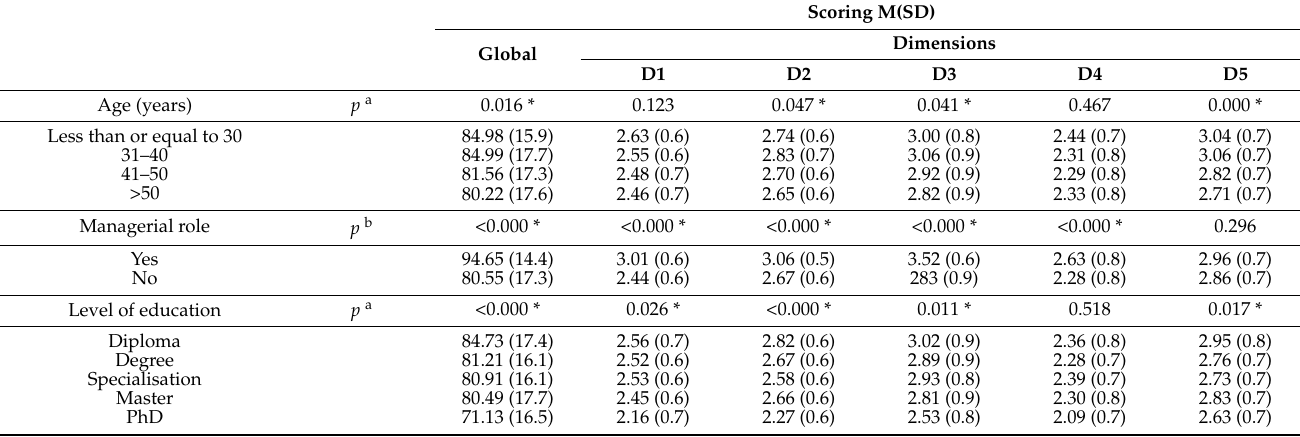
Table 2. Bivariate analysis of the results from PES-NWI and the sociodemographic and professional variables. Scoring M(SD) Global